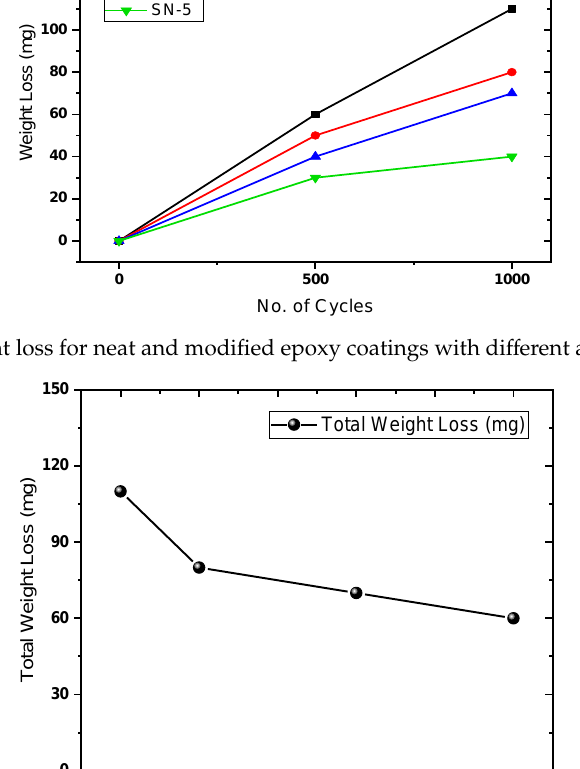
Figure 7. Mass loss with different nanoparticle percentages.